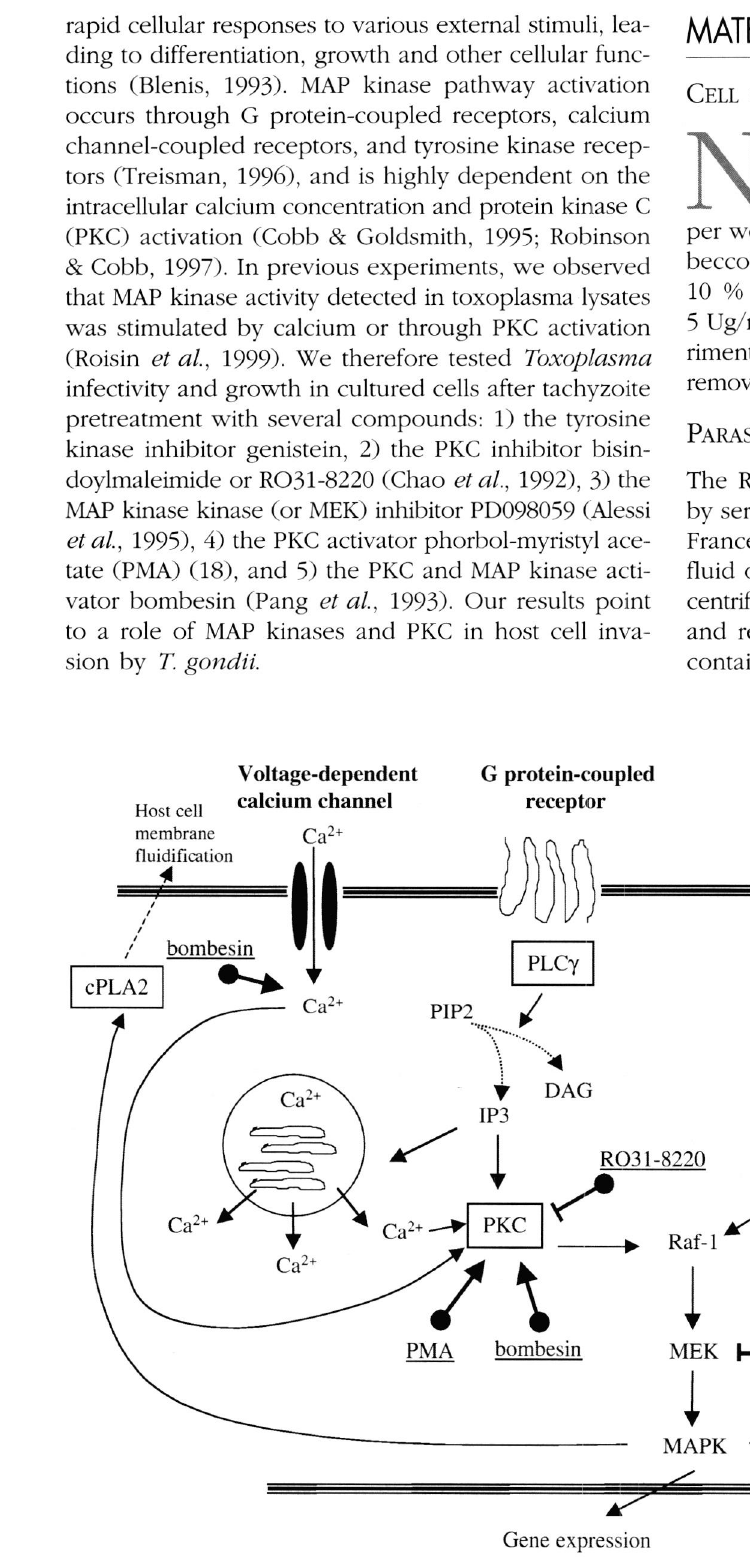
Fig. 1. - Biochemical targets of the different kinase activators (•-•) or inhibitors (•—I) used. Three main signalling pathways are concerned: the tyrosine kinase receptors pathway, the G protein-coupled receptors pathway, and the voltage-dependent calcium channels